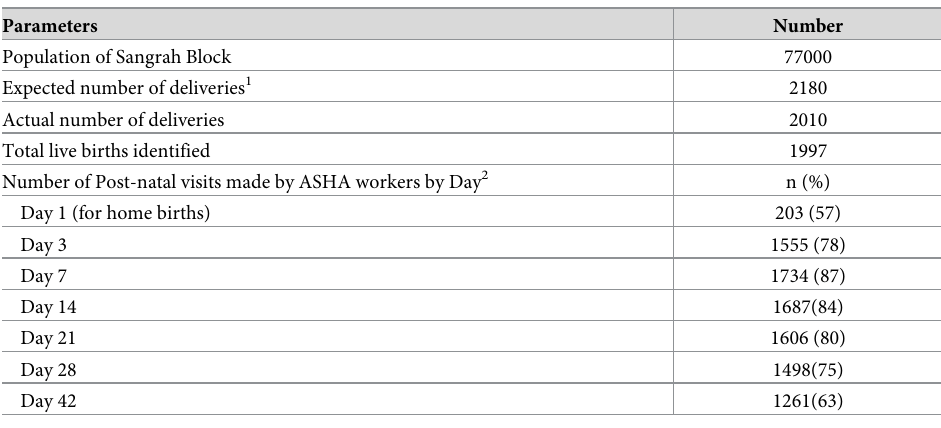
Table 1. Study population